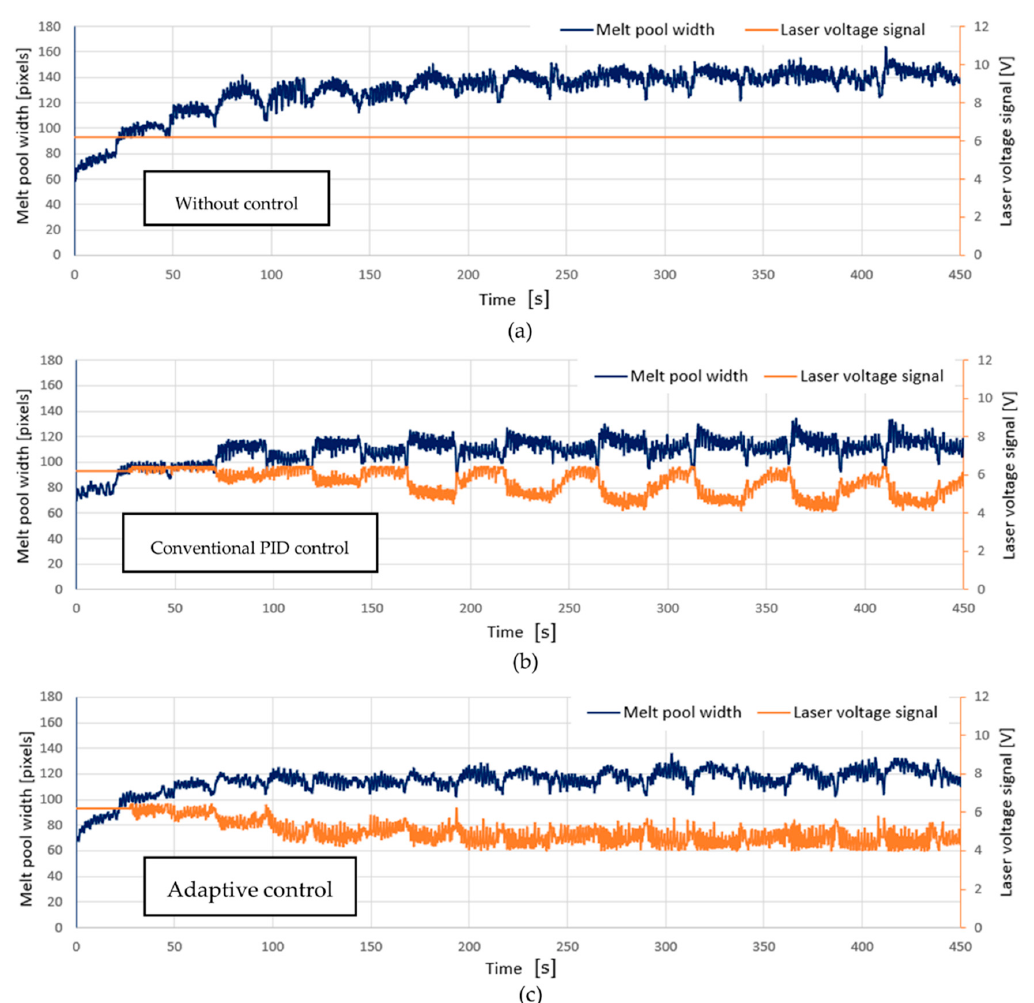
Figure 9. Time plots of the MPW and laser voltage signals for Experiment 2 (solid semicylinder without the profile tool path, 316 L stainless steel). ( a ) The data without control; ( b ) The data with conventional PID control; ( c ) The data with the proposed adaptive control.